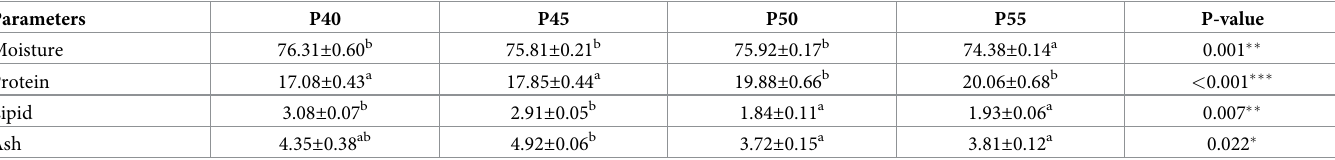
± SD. Different superscripts on the same row indicate there is a significant difference.